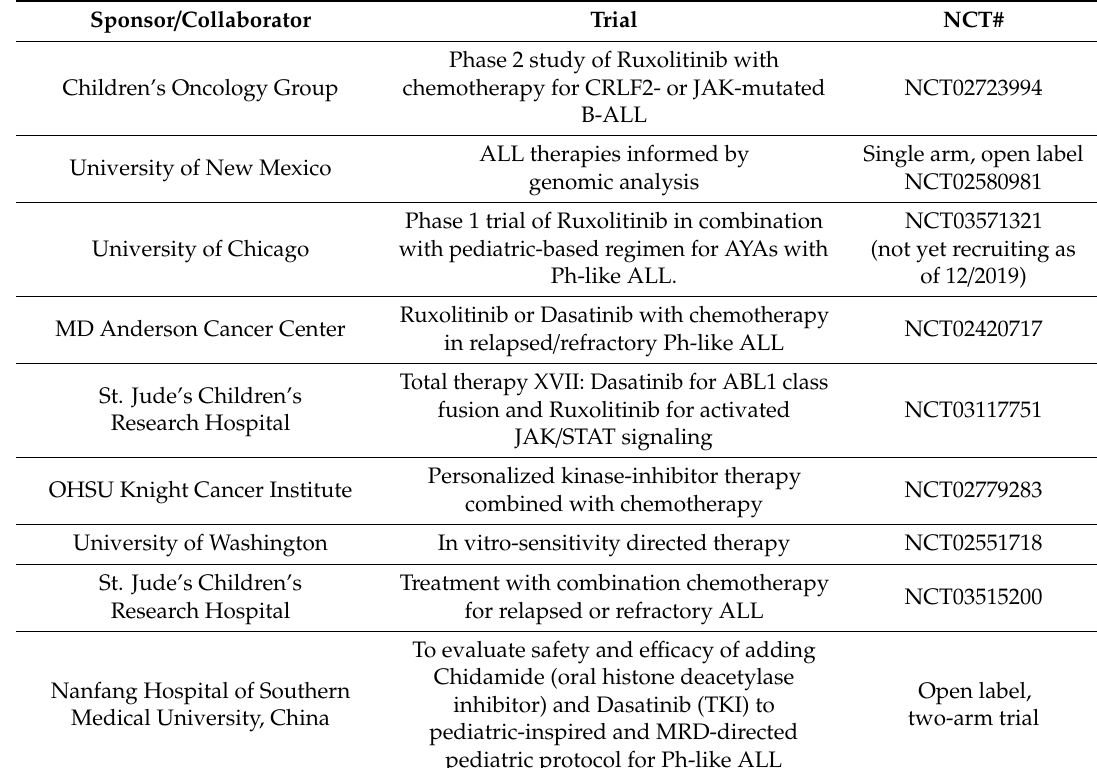
Table 3. Ongoing clinical trials of Ph-like ALL